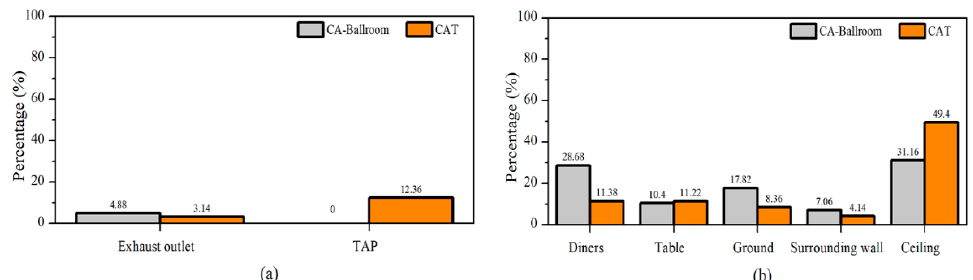
Figure 13. Particle distribution statistics for CA-Ballroom and CAT: ( a ) percentage of particles discharged from the exhaust outlets and purified by the purifier; ( b ) percentage of particles deposited on different surfaces.